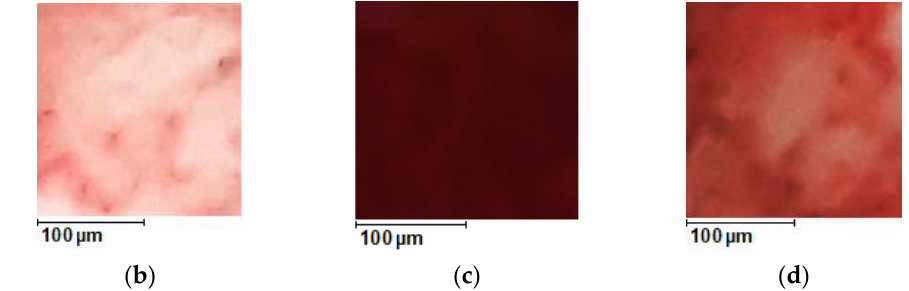
Figure 13. Photos of the area of the samples of the cat ovaries, magnified 50 times: F-ph ( a ) before optical clearing; ( b ) after optical clearing; L-ph ( c ) before optical clearing; ( d ) after optical clearing. The optical clearing agent is 99.5% glycerol.